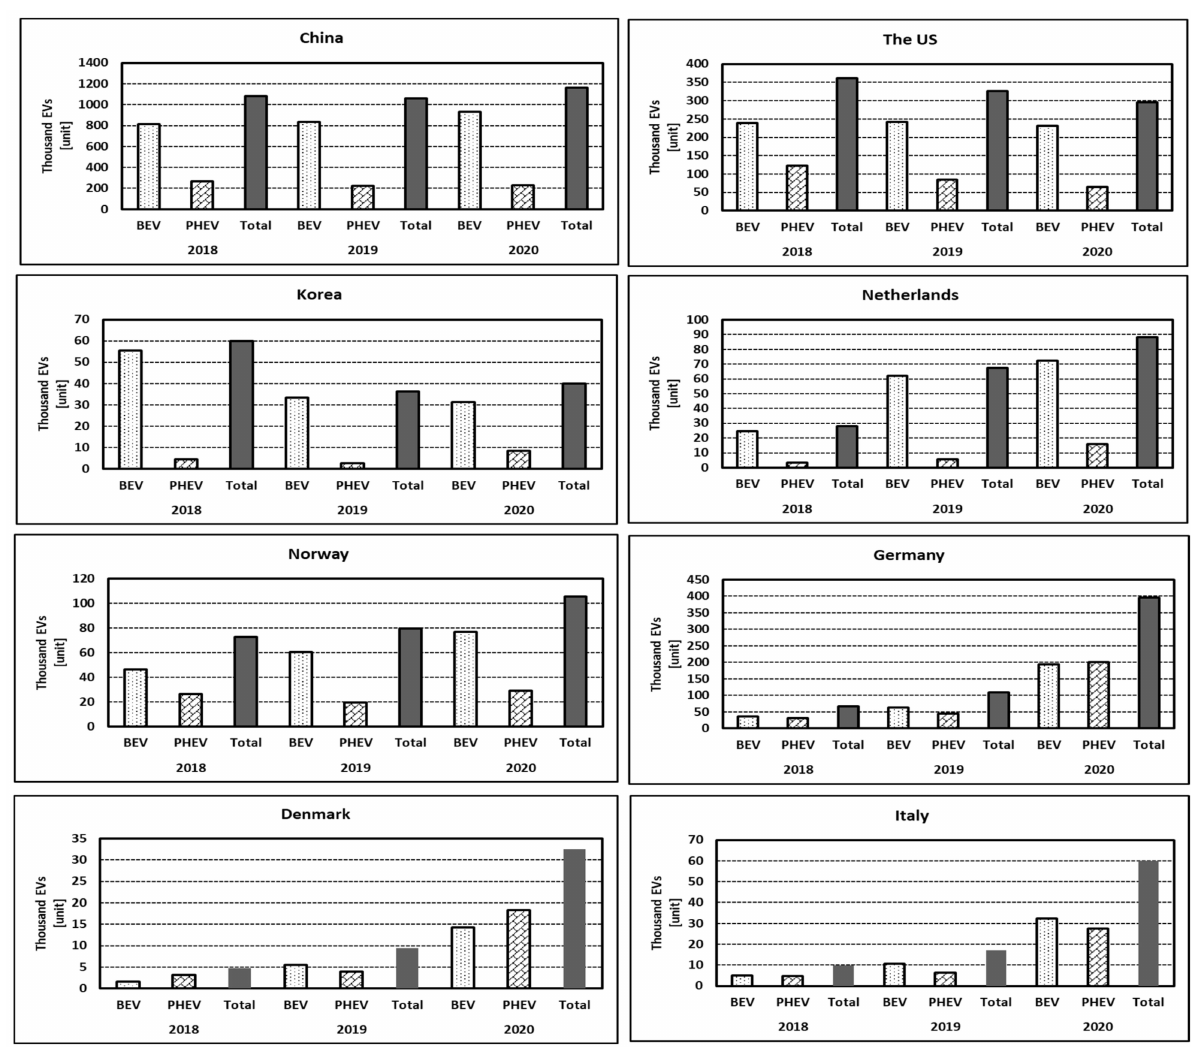
Figure 4. Global EV registration.